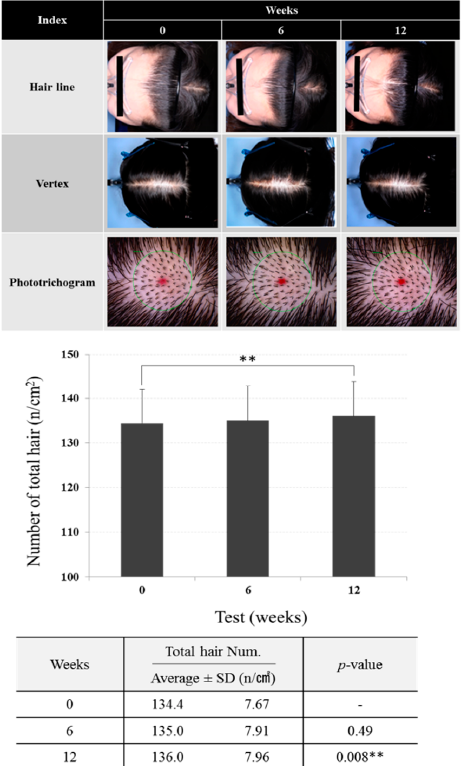
Figure 4. Images of change in hair pattern following the application of scalp tonic for 12